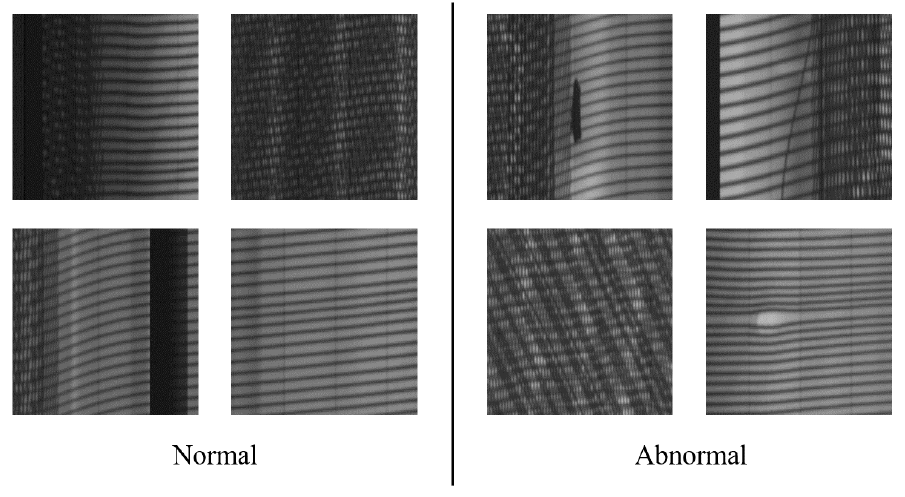
Figure 8. Normal and abnormal examples of the dataset used in this paper. They are grayscale images in the shape of 256 × 256 ×